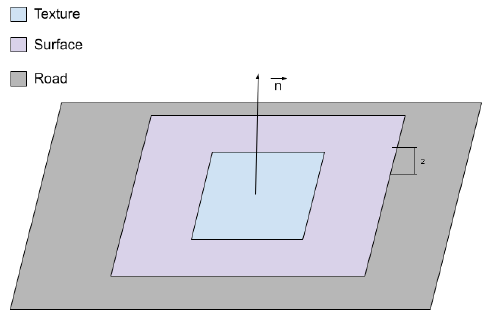
Figure 10. Texture placement schema for the visualization of traffic signs with Potree.